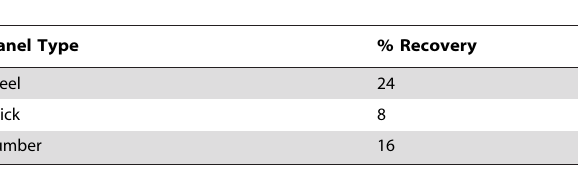
Table 2. Spores recovered in the runoff.